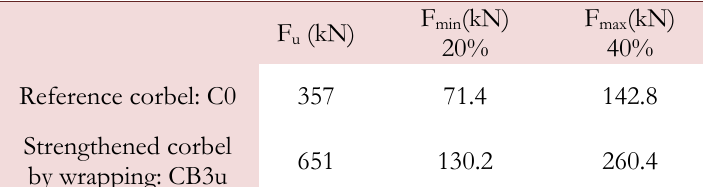
Fig. 4 described the comparison of behavior between reinforced concrete corbels "C0" loaded in static and dynamic tests. There is a change in slope at 60 kN for unstrengthened corbel in static loading. In fact, after one million cycles of